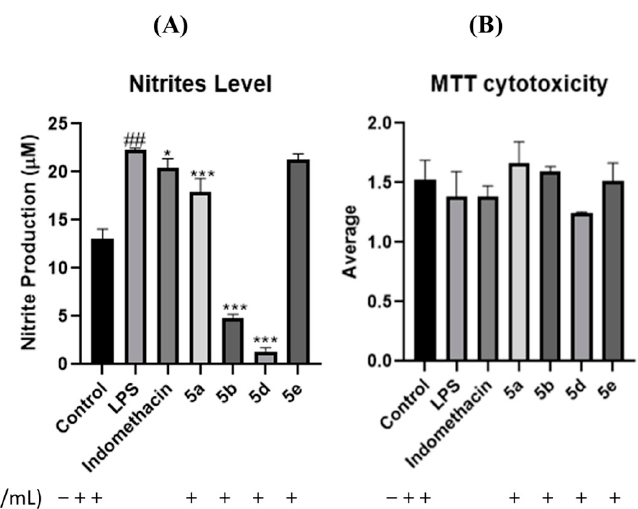
Figure 4. Evaluation of NO production and cell viability in LPS-stimulated RAW264.7 macrophages of Ibuprofen conjugates. ( A ) A concentration of 40 µ g/mL of ibuprofen conjugates ( 5a , 5b , 5d , and 5e ) and indomethacin (positive control) was used for the treatment of LPS-stimulated RAW264.7 macrophages. The Griess method was used to evaluate the nitrite content in cell supernatants. Significant differences indicated in the graphs are all in comparison to LPS-stimulated cells only. ( B ) A concentration of 40 µ g/mL of ibuprofen conjugates and indomethacin (positive control) was used for the treatment of LPS-stimulated RAW264.7 macrophages. Cytotoxicity of the macrophages was evaluated using an MTT assay. No significant cytotoxicity was observed for LPS-stimulated cells only (designated as ##)., Ibuprofen conjugates and indomethacin (positive control) in comparison to control. Values are mean ± SD ( n = 3). * p < 0.05, *** p < 0.001.